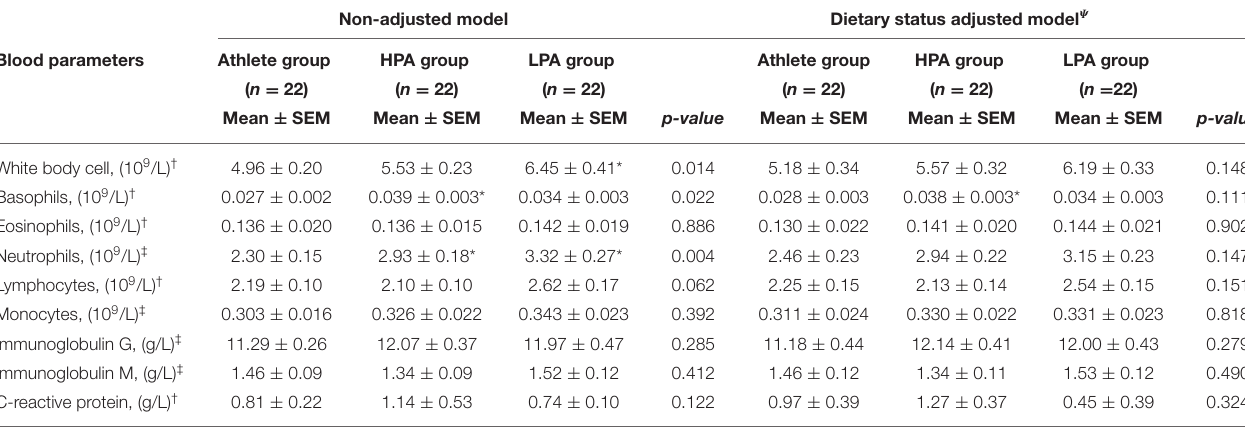
TABLE 4 | Blood biomarkers with significant difference among athletes and young adults before and after adjusting dietary